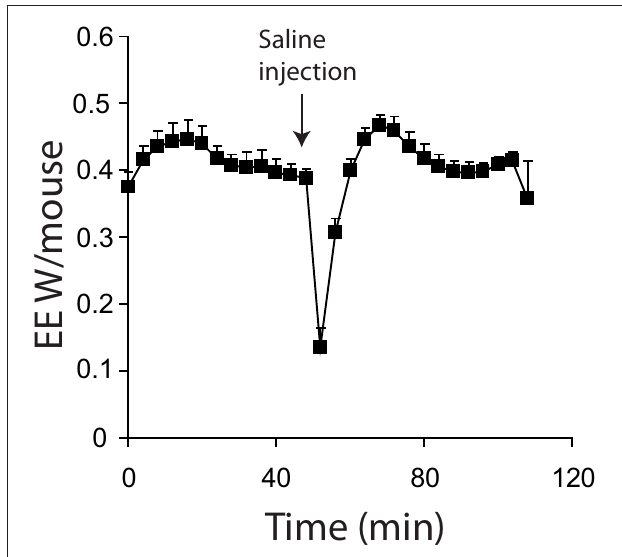
FIGURE 4 | Energy expenditure of 7 mice acclimated and measured at 21 ◦ C. All mice were conscious during the experiment. Mice were injected with saline where indicted. All mice; male, C57Bl/6, 4 months of age, chamber volume 6.2l. Energy expenditure measurements conducted using a custom built calorimetry system, using a paramagnetic oxygen analyser and infrared carbon dioxide detector. Flow rate was 0.4l/min and measured on incurrent air to the